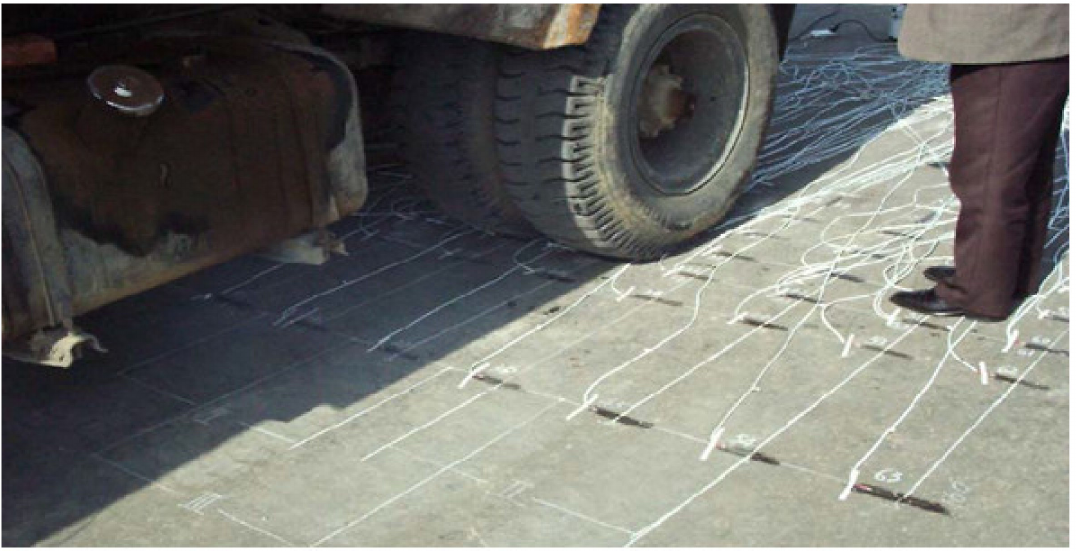
Figure 7. Surface strain measurement for epoxy asphalt mixture pavement.